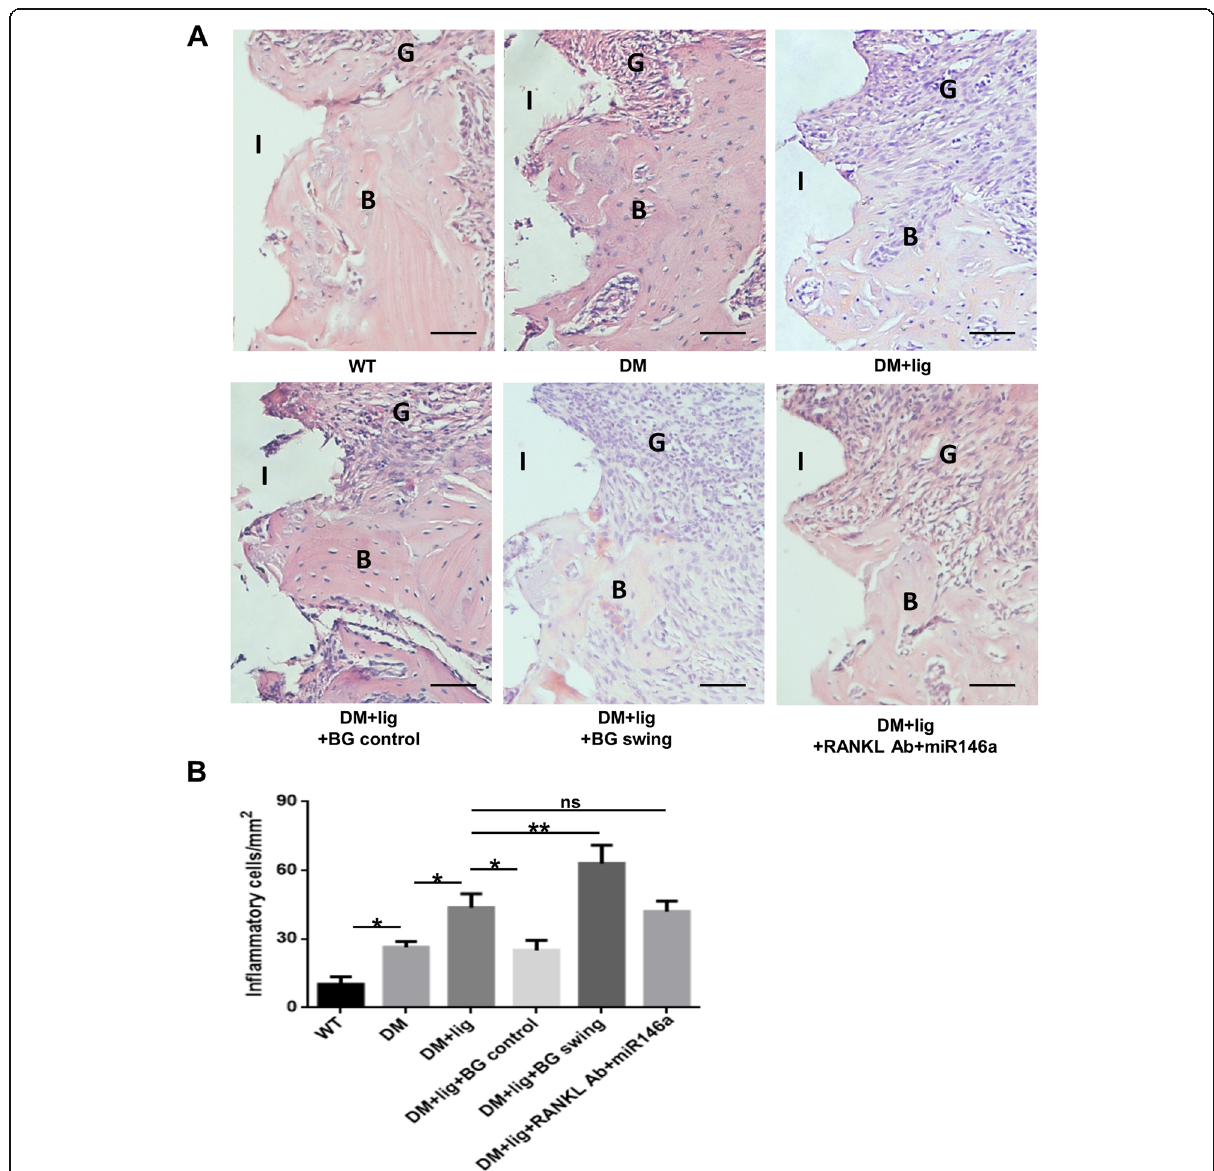
Fig. 2 Inflammatory infiltrate in peri-implant tissues was examined using H&E staining. A Images of tissues surrounding implants in different groups of mice. B Numbers of infiltrated inflammatory cells in peri-implant tissues were analyzed (mean ± SD, n = 3, * p < 0.05, ** p < 0.01; ns, no significance; I, implant space; B, bone; G, gingiva. Scale bars, 50 μ